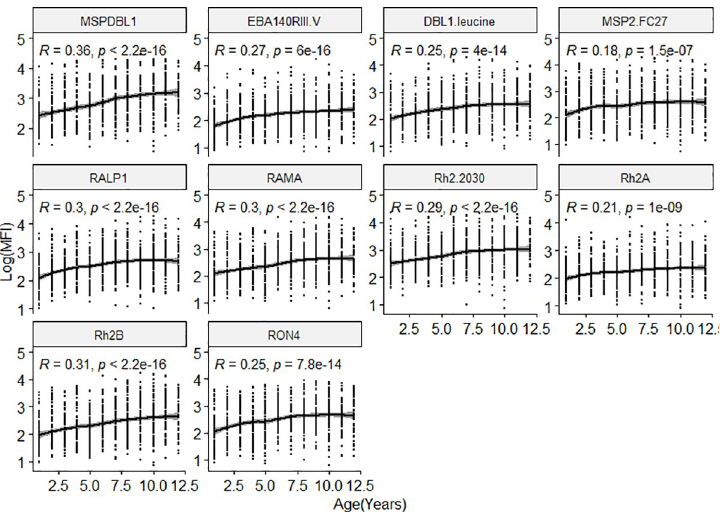
Fig 2. Distribution of IgG levels (log-transformed MFI) as a function of age. Overall differences of antibody levels to the ten antigens tested with age in the study population. The regression line shows the LOESS smoothed estimate of the log transformed MFI.